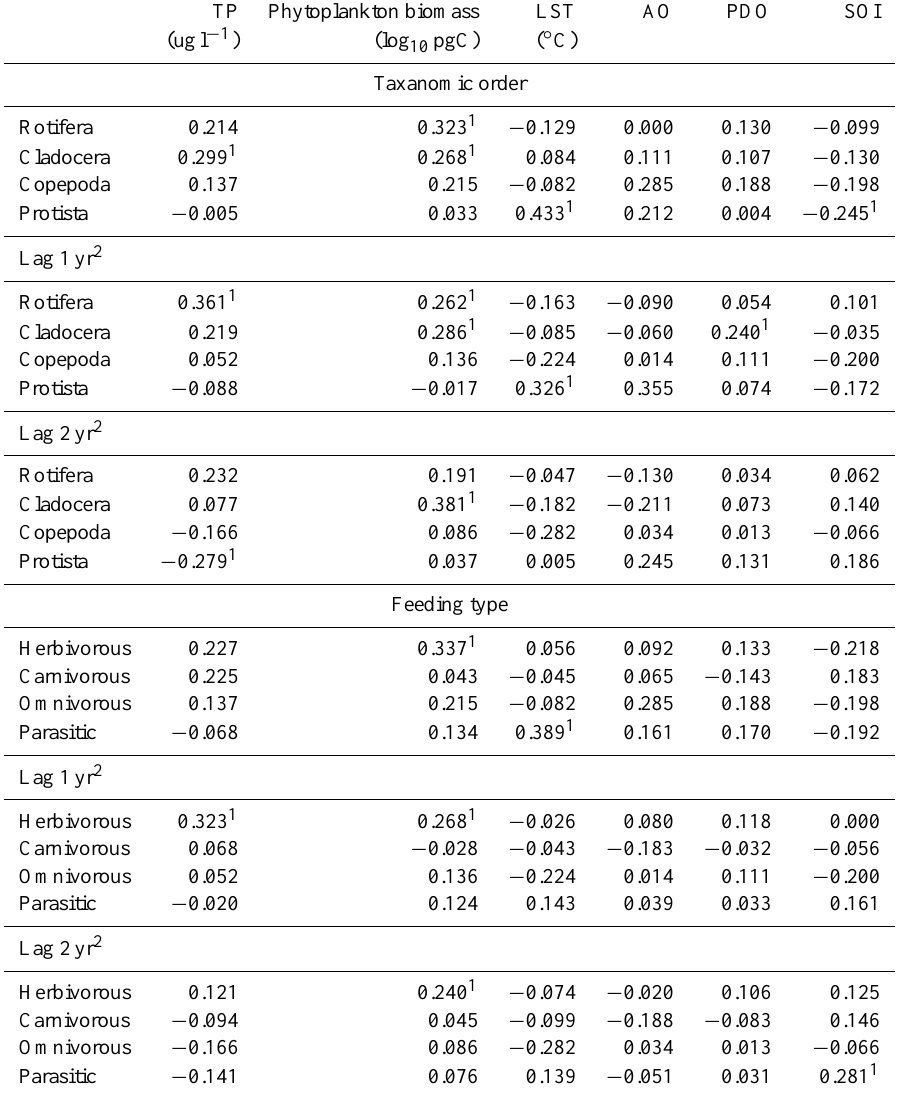
Table 2. Results of correlation analyses of zooplankton abundances, categorized according to their feeding types and taxonomic order versus environmental